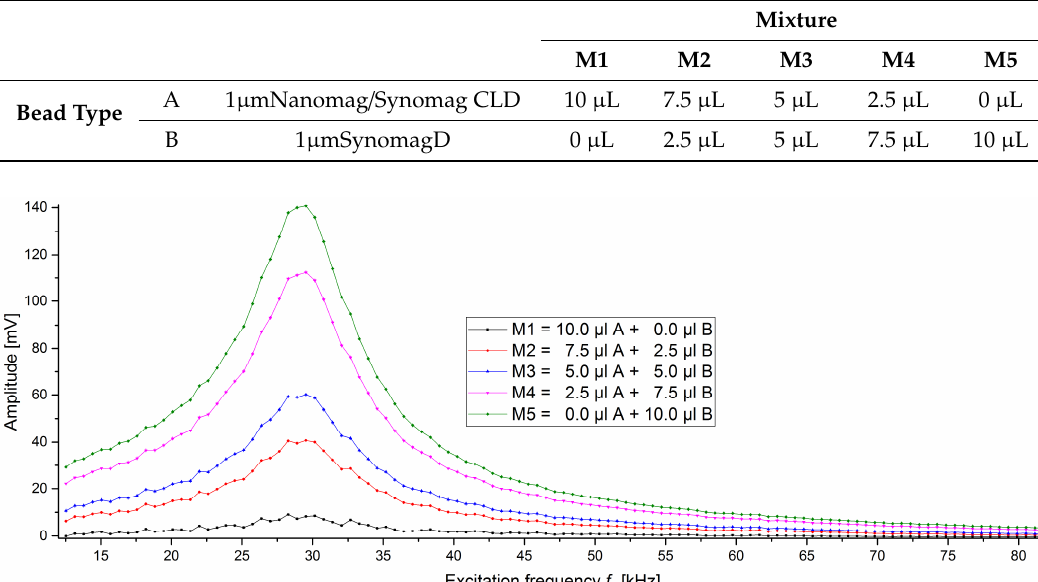
Table 2. Amount of the two bead types in samples M1 to M5. The total volume of the bead solution was always 10 µL pipetted into 400 µL of distilled water.